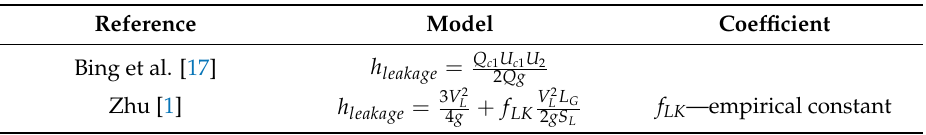
Table 3. Leakage loss models in literature.